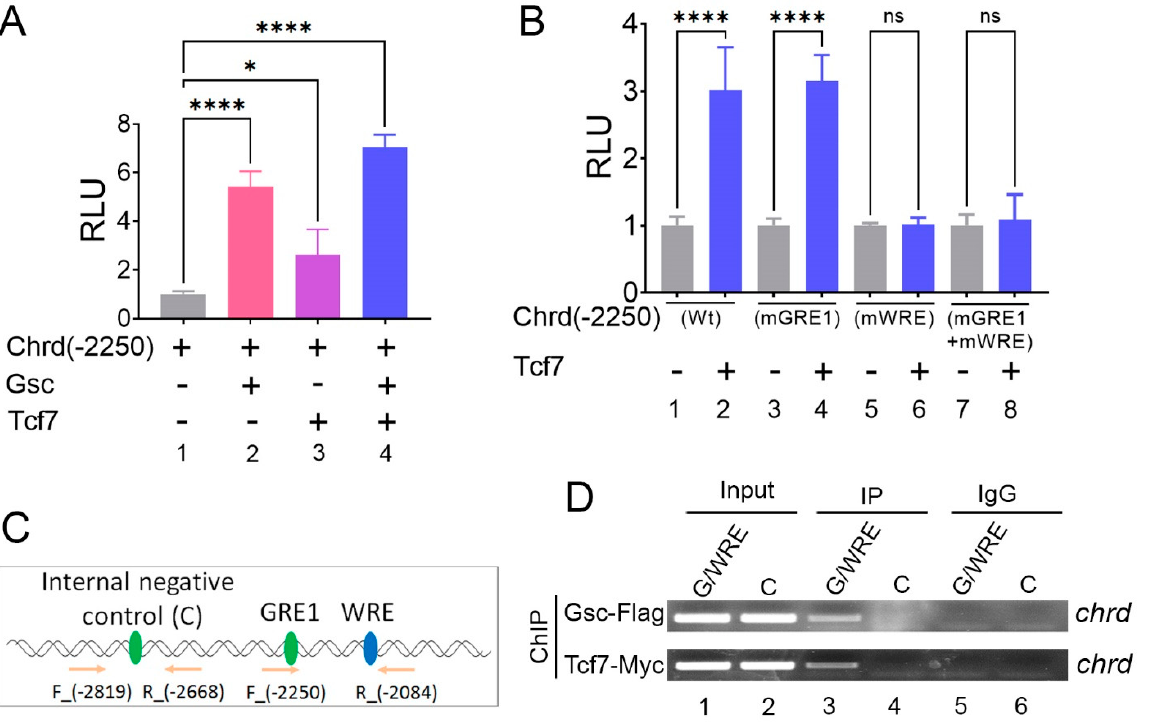
Figure 5. Tcf7 binds to WRE to activate chrd transcription. ( A ) Relative luciferase activity of chrd(-2250) promoter constructs with Gsc and Tcf7. ( B ) Relative luciferase activity of chrd(-2250)mGRE1 and chrd(-2250)mWRE constructs with Tcf7. ( C ) Schematic representation of designing the ChIP-PCR primer for GRE, WRE, and the internal negative control. ( D ) Chromatin immunoprecipitation (ChIP) assay was performed to test the occupancy of Gsc-Flag and Tcf7-Myc to GRE/WRE within the promoter region of chrd . * p ≤ 0.1, **** p ≤ 0.0001, and n.s. denotes nonsignificant values.